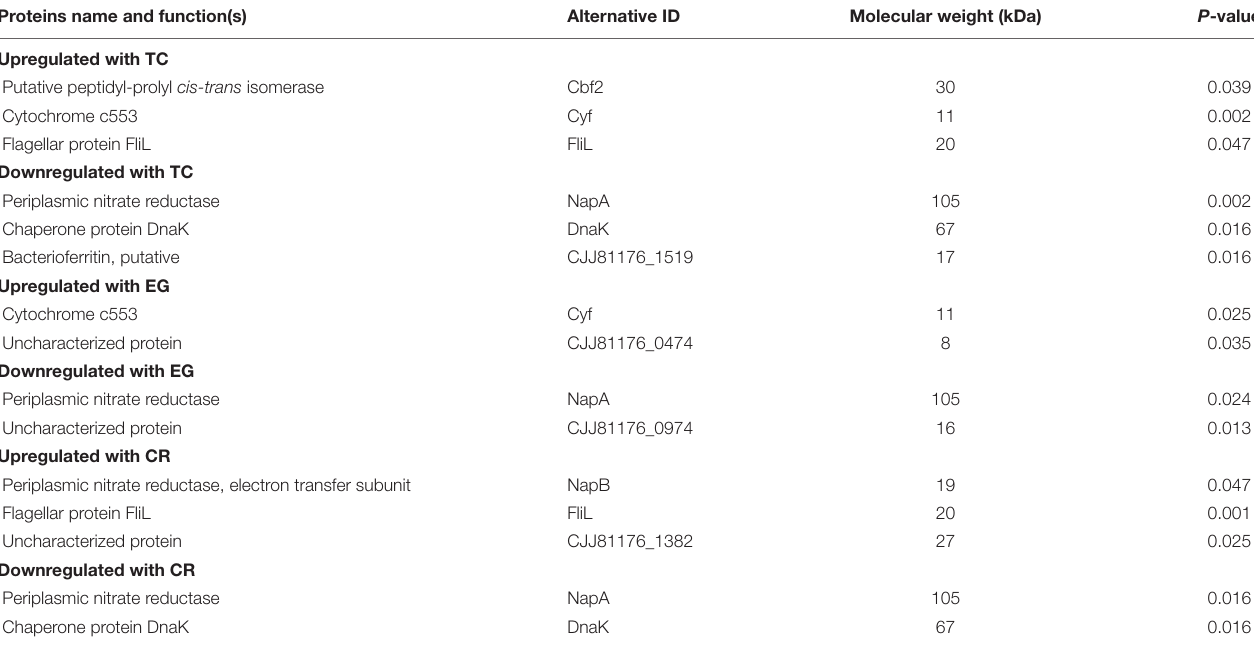
TABLE 4 | List of identified proteins significantly altered in C. jejuni NCTC 11168 biofilms treated with TC, EG, or CR as compared to untreated (control) biofilms. Proteins name and